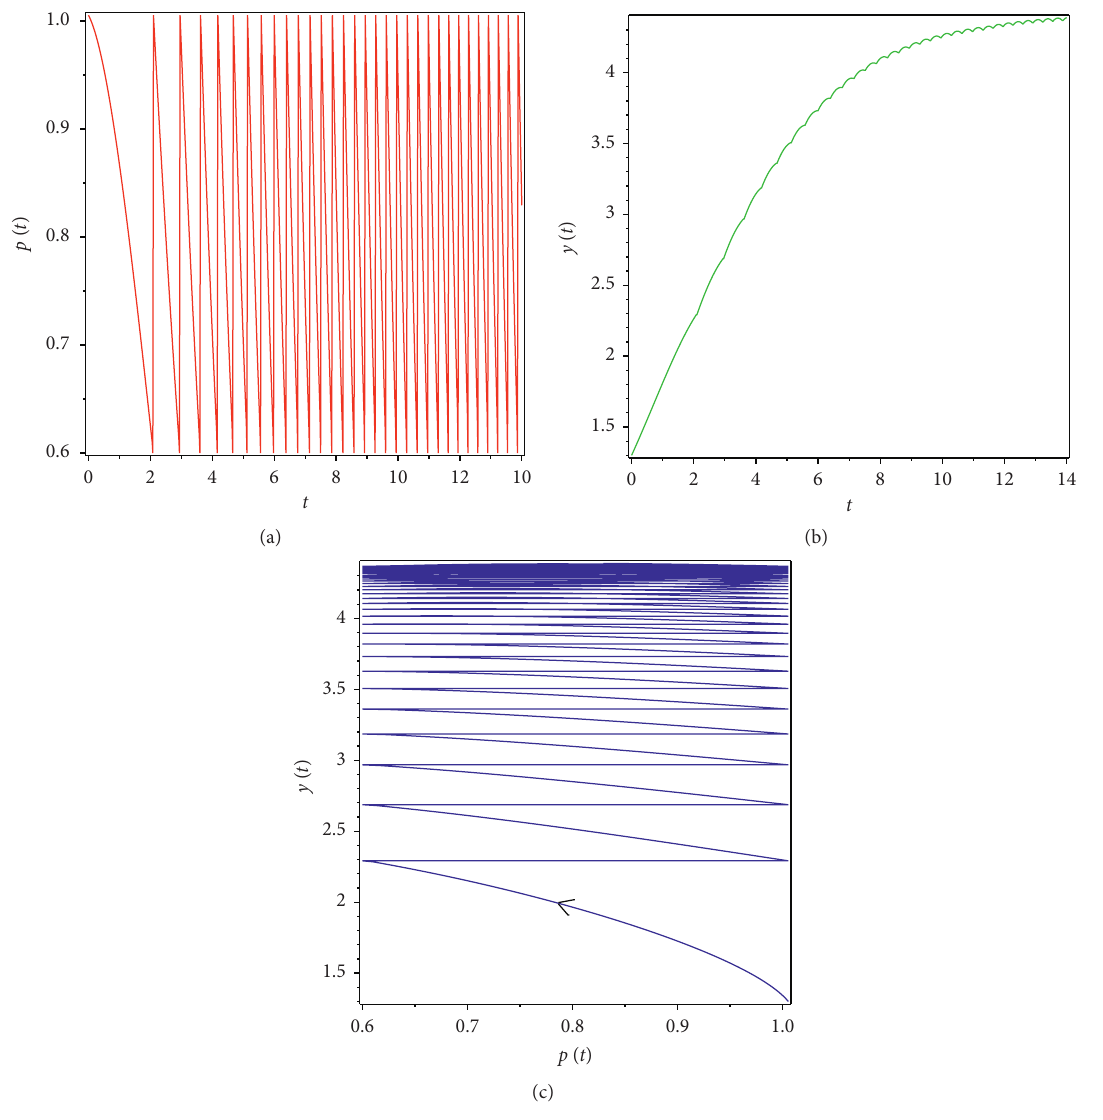
8: Phase portrait and time series when not hunting herbivores. And the parameters